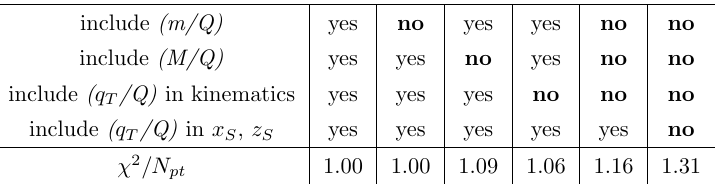
Table 7 . Comparison of results of the (cid:12)t with di(cid:11)erent combination of power suppressed terms. The (cid:12)t is made only for the central values, with (cid:12)xed TMD evolution and TMDPDF as in NNPDF3.1, with DSS collinear